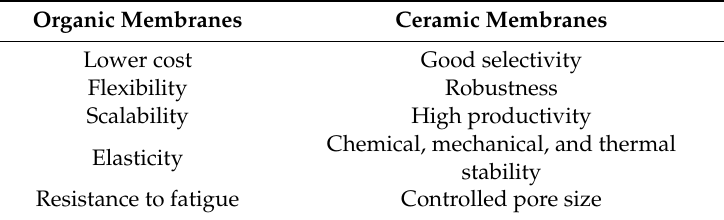
Table 1. Main advantages of organic and ceramic membranes